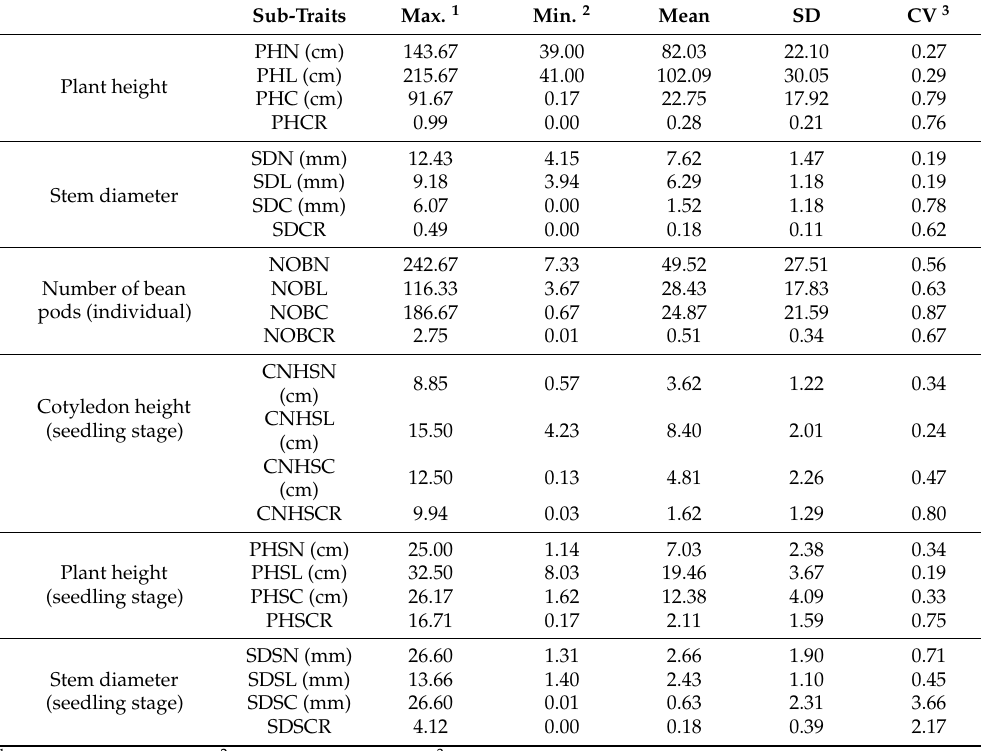
Table 1. Variation of 185 representative accession materials for traits related to stalk development under normal and low-light conditions.